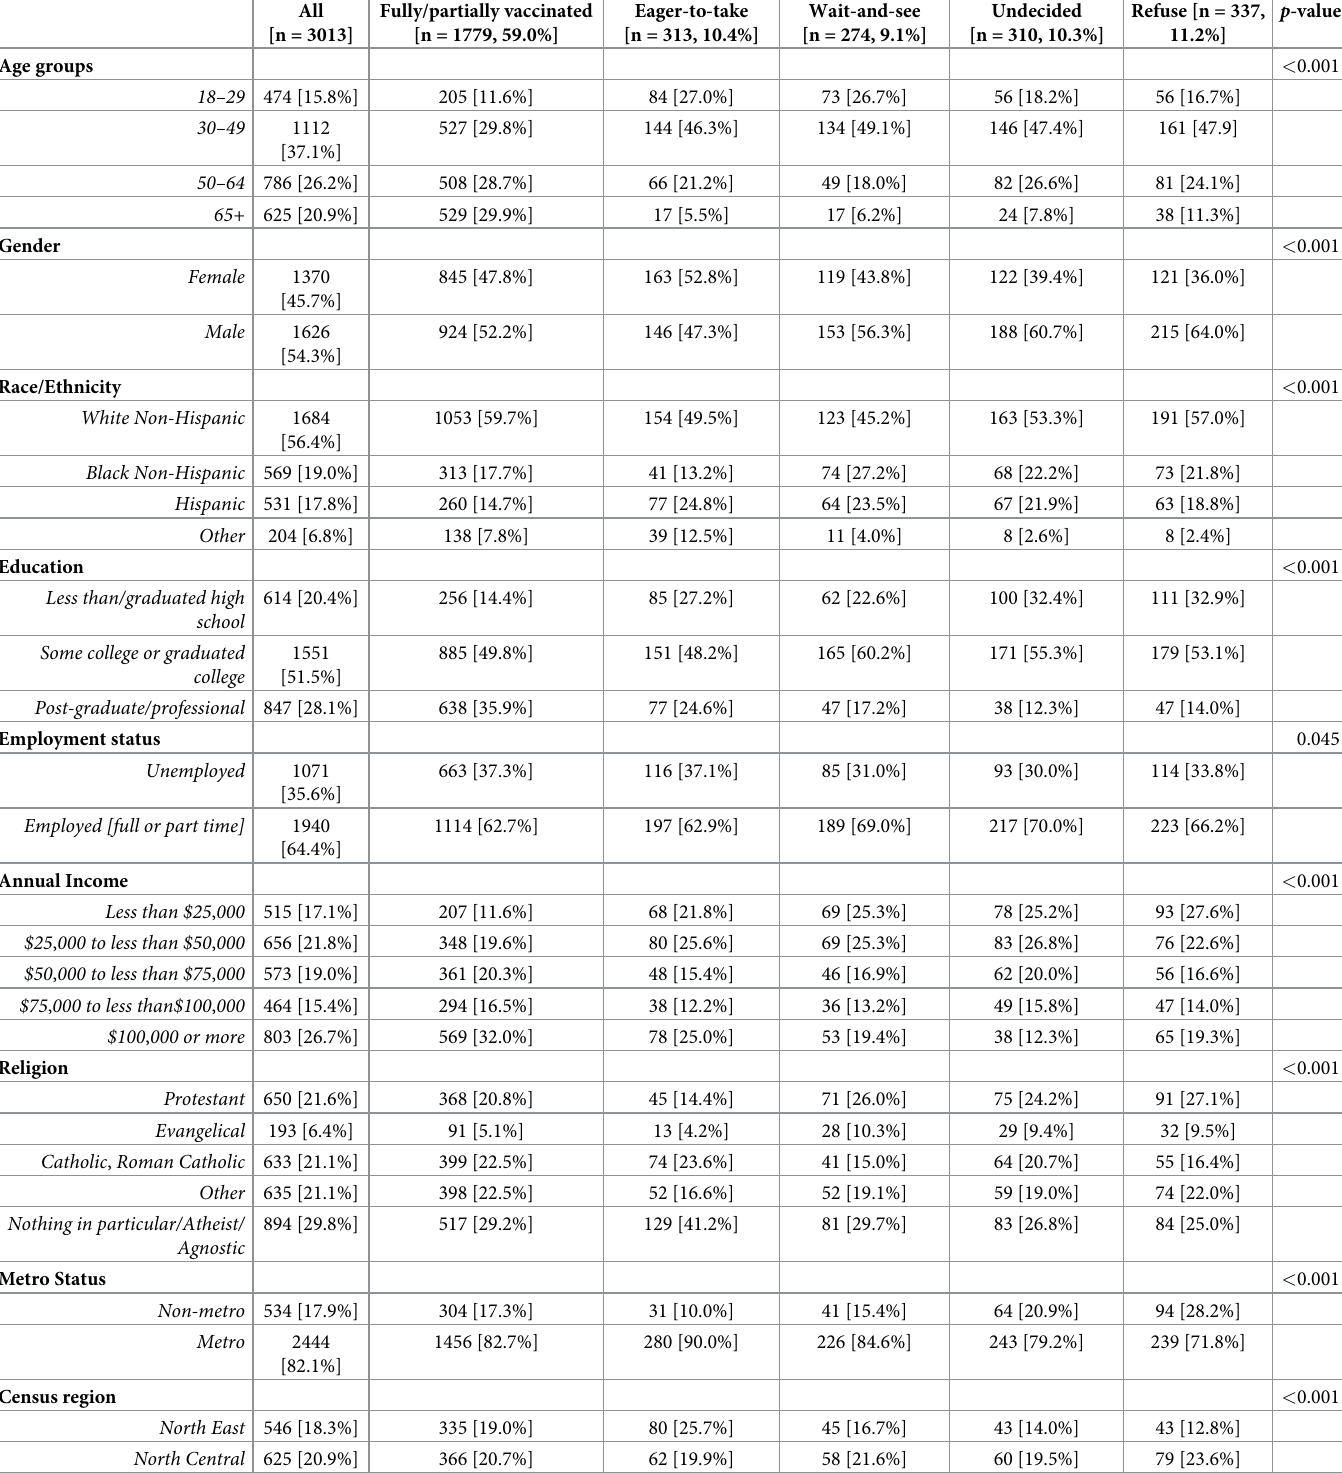
Table 1. Sociodemographic characteristics and COVID risk perception of the samples by vaccination